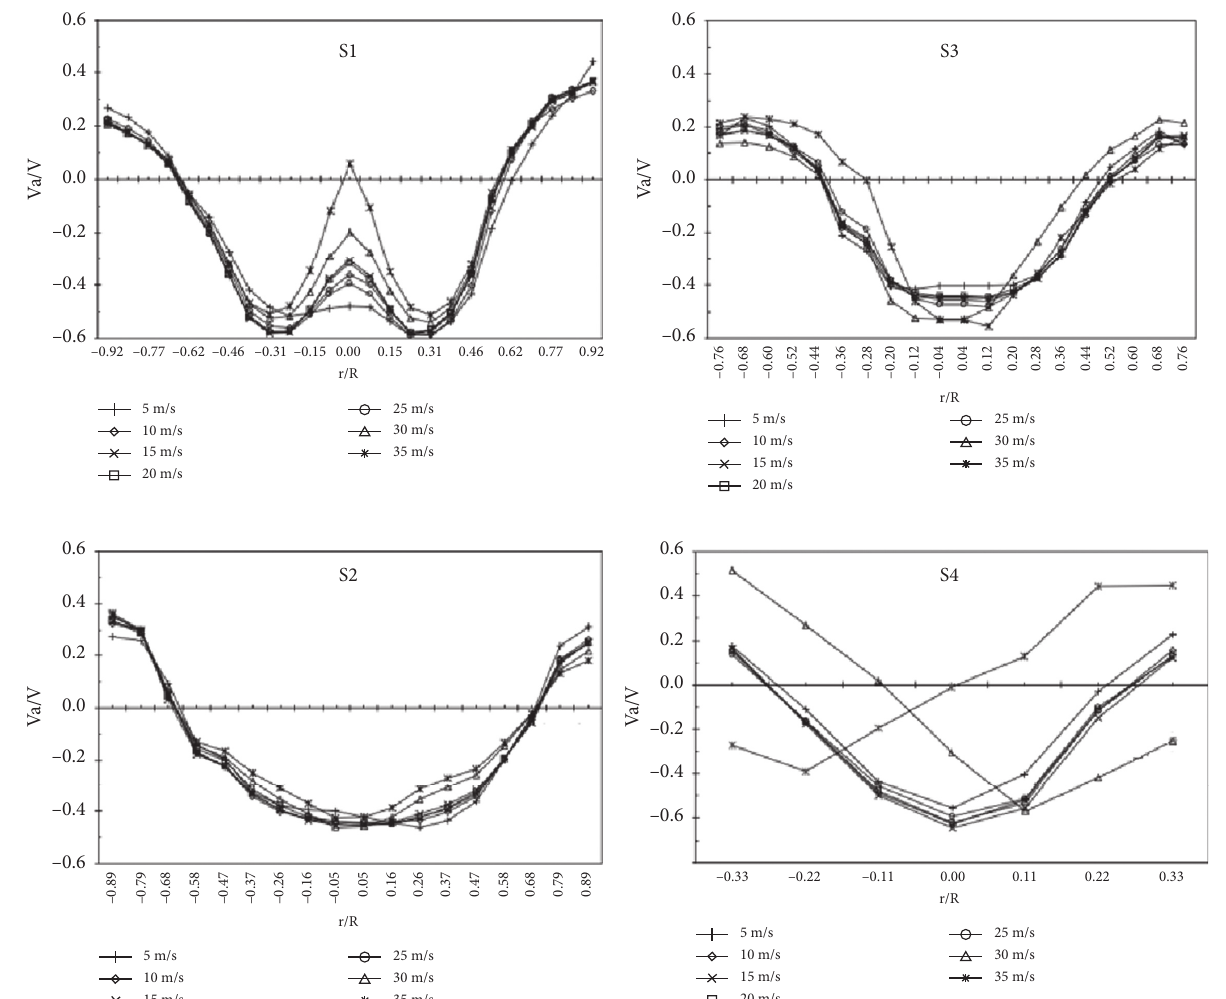
Figure 6: Axial velocity profiles for different cross sections at different inlet